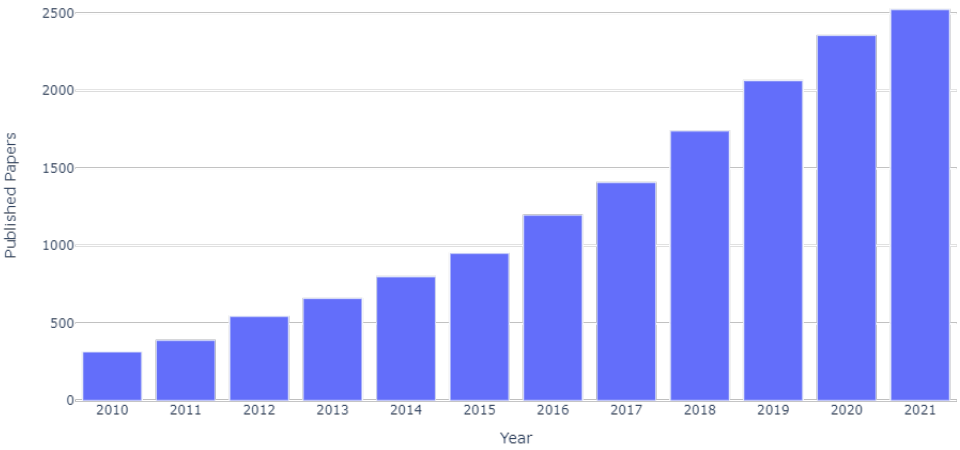
Figure 2. Number of research papers using data-driven approaches for building energy